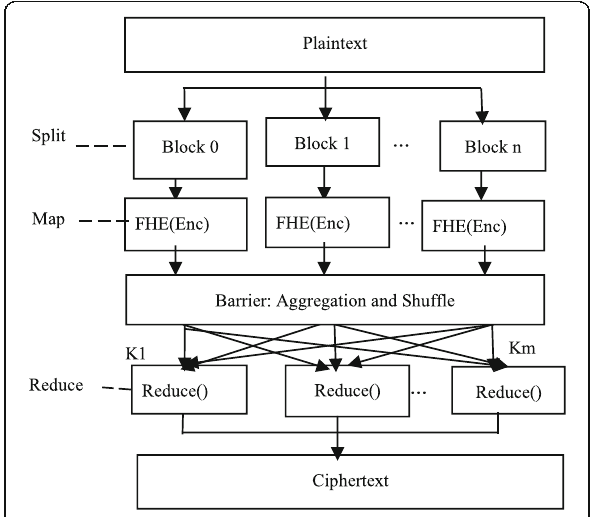
Fig. 1 Parallel encryption process of floating-point number. The encryption process is mainly divided into three parts, split, map and reduce, where map and reduce are parallel